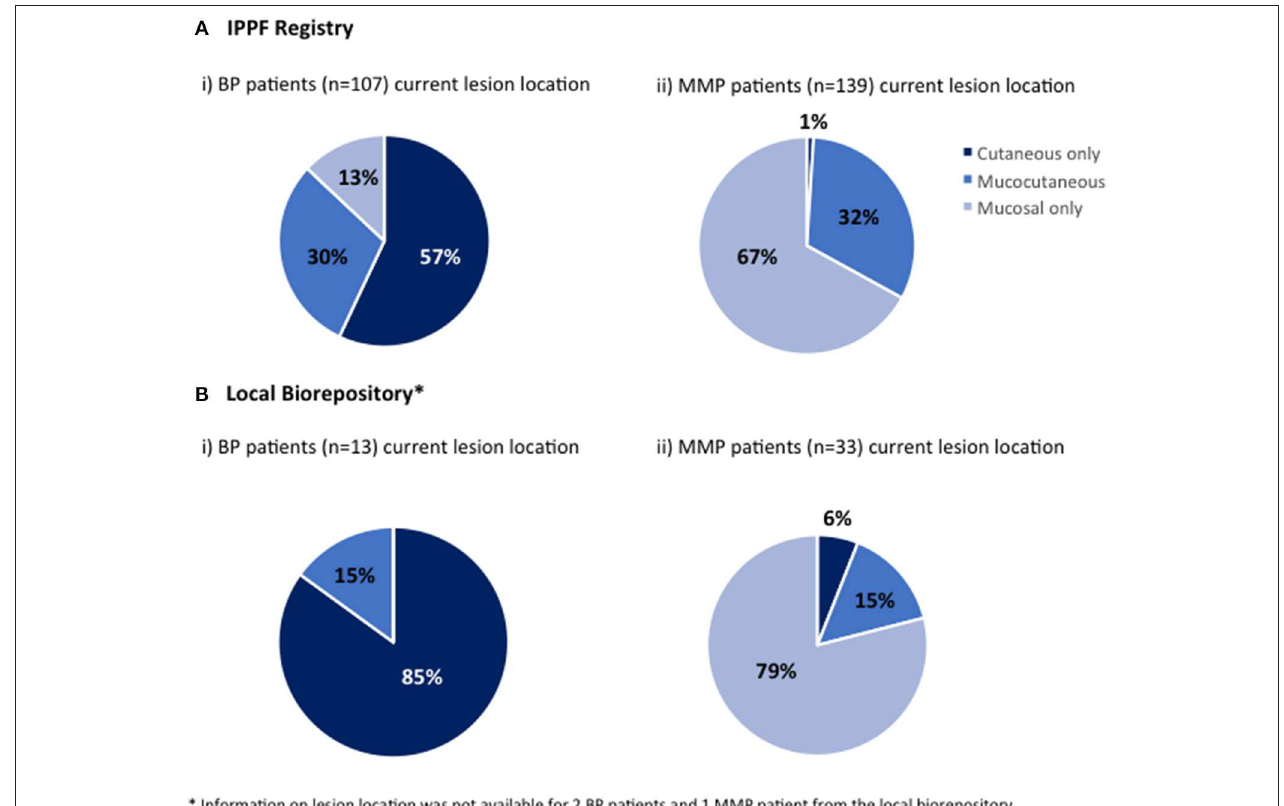
FIGURE 2 | Lesion location. Patients were divided by lesion location into those who at the time of enrollment experienced mucosal lesions only, cutaneous lesions only or both mucosal and cutaneous lesions (mucocutaneous); ( A -i) BP patients in the IPPF registry, ( A -ii) MMP in the IPPF registry, ( B -i) BP patients in the local biorepository, ( B -ii) MMP patients in the local biorepository.